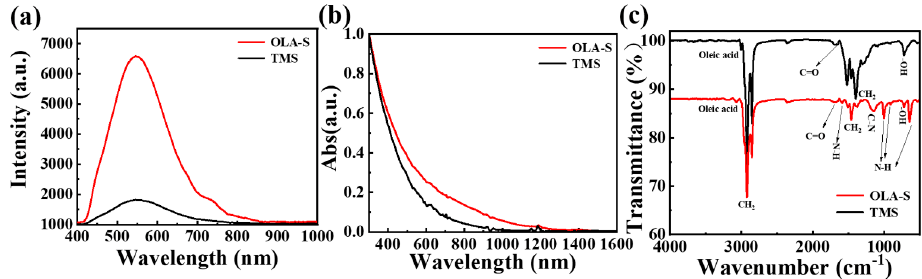
colloidal AgBiS 2 NCs.